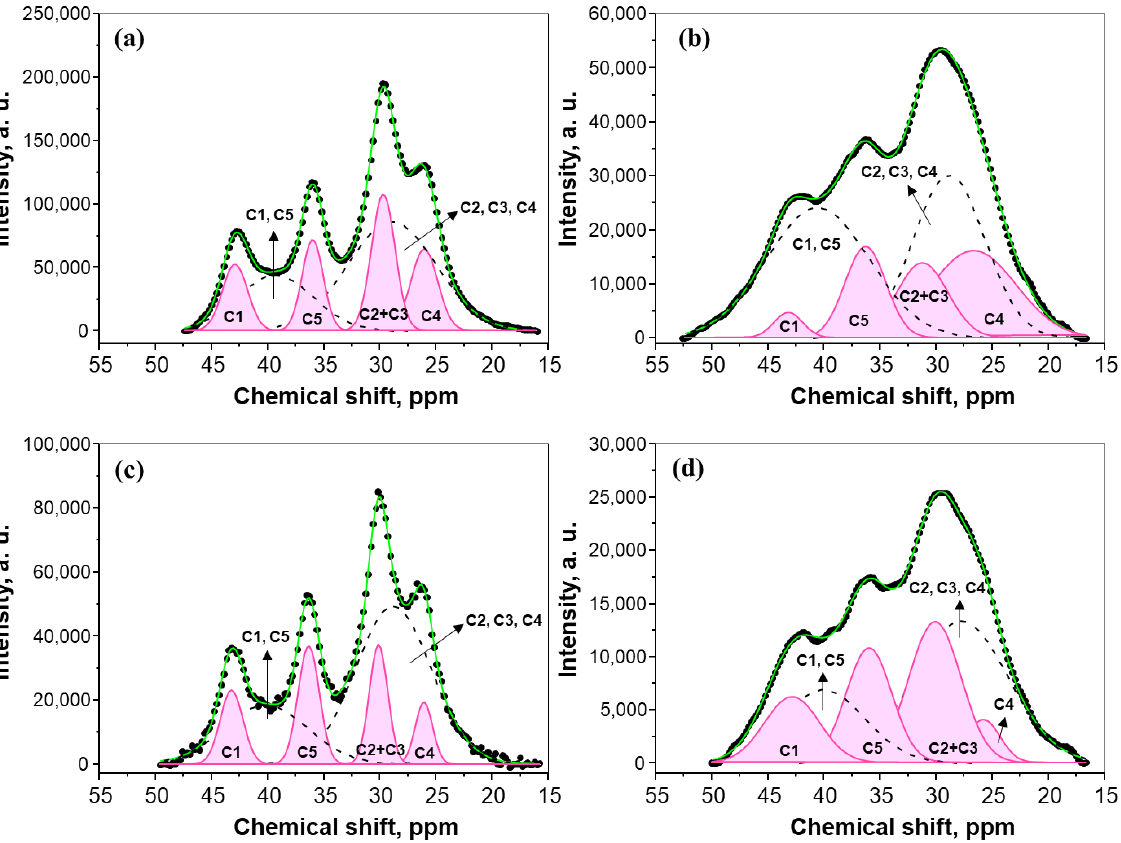
Figure 5. Aliphatic region of the 13 C CP/MAS spectra of: ( a ) neat PA6 and such loaded ( b ) Al10, ( c ) Cu10, and ( d ) Mg10 PA6 MP: experimental (black dots) and computed (green line) spectra. The pink-shaded Gaussians represent the peaks of the indicated carbons in the crystalline regions, and the black dashed lines are the curves used to deconvolute the signal from amorphous domains (see Figure 4). Table 4 contains the identification and quantification of all resonance lines in this figure.